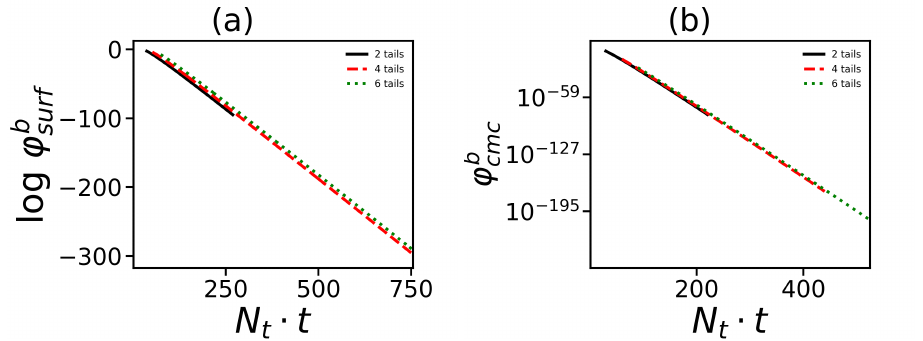
Figure 4. Dependence of ( a ) the volume fraction (dimensionless) ϕ b and ( b ) the critical micelle concentration ϕ b c . m . c . on the overall number of monomeric units in all tails at different numbers of tails. Data for the same generation number G = 4 are